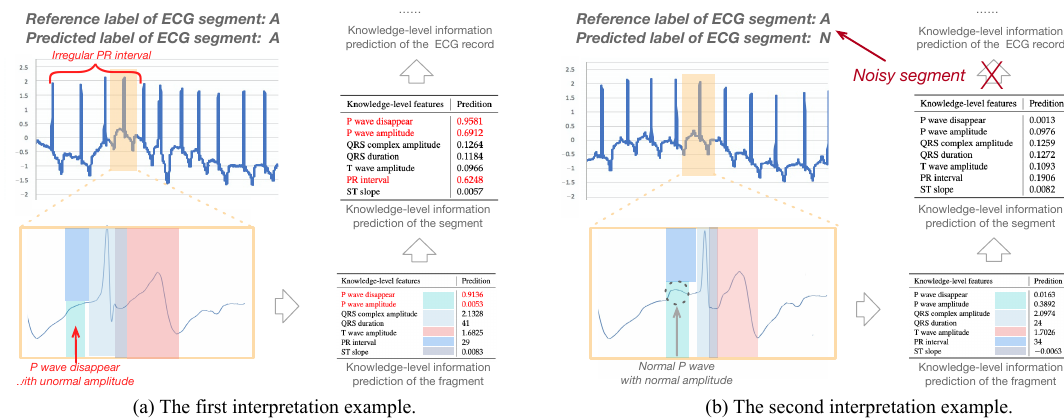
Figure 8. Case studies of prediction interpretation on the Atrial Fibrillation Monitoring